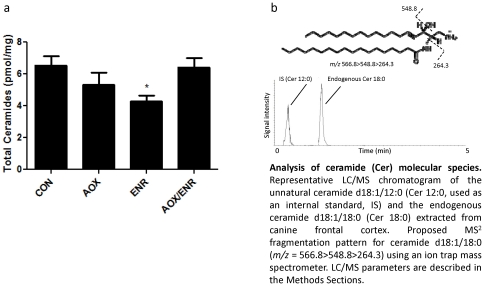
Effect of ENR and AOX on ceramide mobilization.
a) Levels of total ceramides in the frontal cortices of aged dogs treated with AOX and/or ENR interventions showed significant reduction in ENR group only (p<0.05). b) Representative LC/MS chromatogram of the unnatural ceramide d18:1/12:0 (Cer 12:0, used as an internal standard, IS) and the endogenous ceramide d18:1/18:0 (Cer 18:0) extracted from canine frontal cortex.